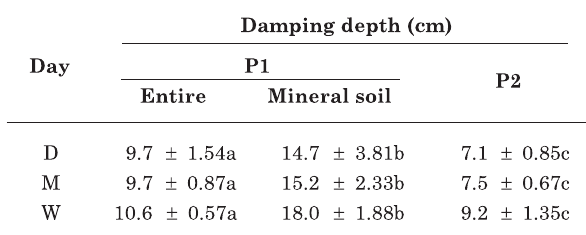
Table 7. Damping depth in soil profiles P1 (entire and mineral soil only) and P2 estimated from measured thermal amplitudes on days D (dry soil), M (moist soil) and W (wet soil), in a pine- forested Haplic Podzol